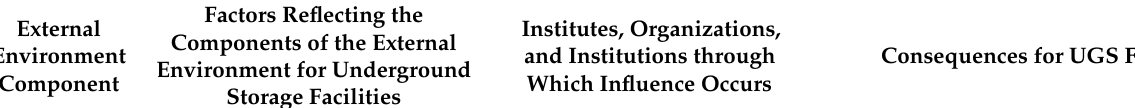
Table 5. Main environmental factors and the nature of their interaction with UGS facilities in